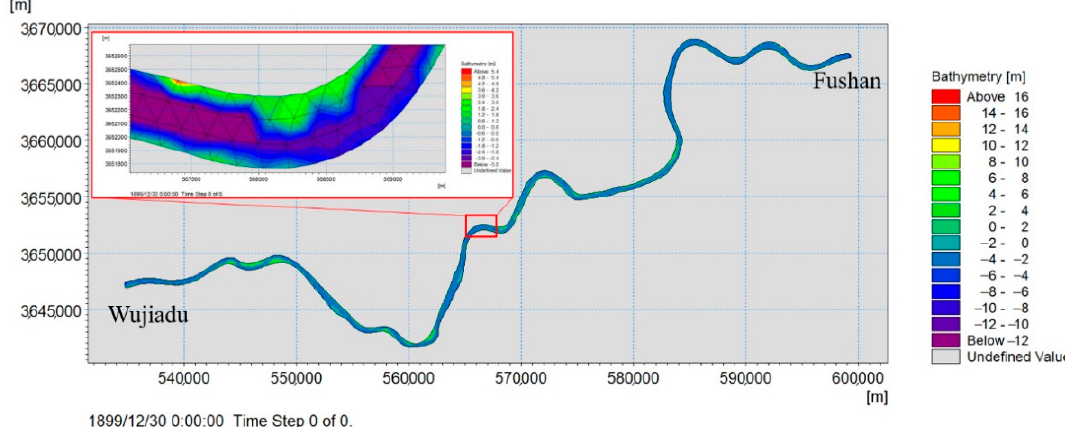
Figure 2. Mesh diagram of the study area.